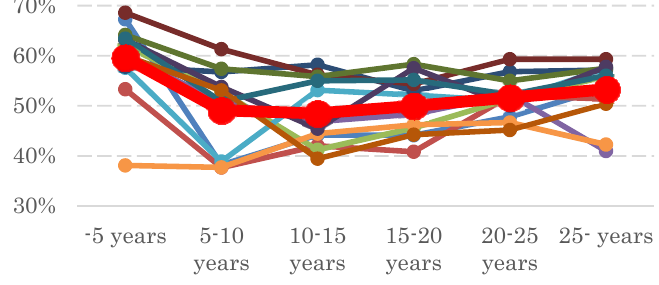
Figure 3. Years of service and “no” percentage of P2